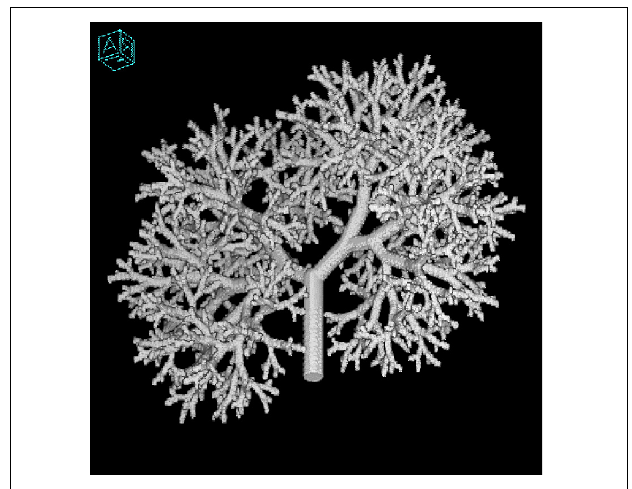
FIGURE 4 | The 512 × 512 pixels lung phantom.